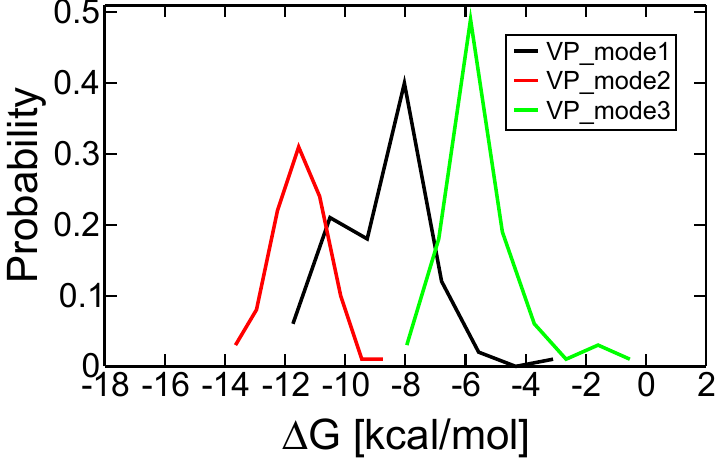
Figure 4. Free energy spectra of the best three binding modes of VP-16 in the TOP2- α cleavage